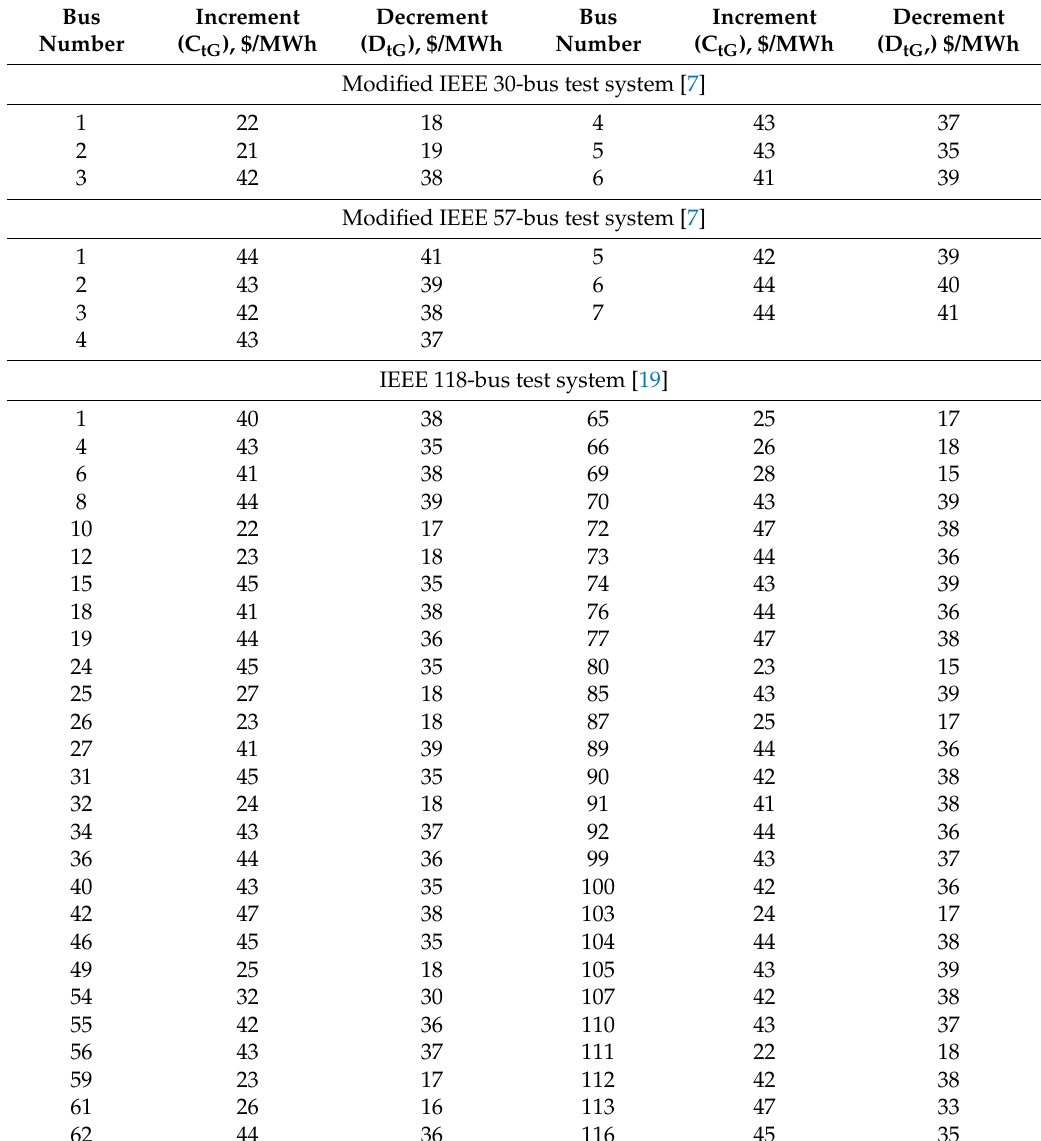
Table A1. Price bids submitted by the generator companies for modified IEEE 30-bus, modified IEEE 57-bus, and IEEE-118 bus test